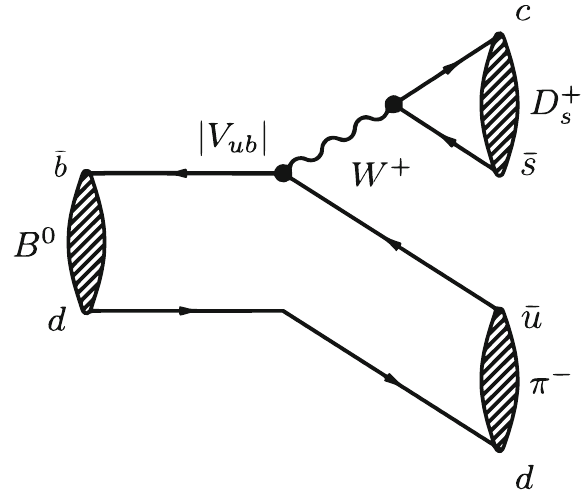
Fig. 1 Tree diagram of the B 0 → D + s π − decay, in which a B 0 meson decays through the weak interaction to a D + s meson and a charged pion. This diagram represents the only (leading order) process contributing to this decay. Strong interaction between the D + s meson and the